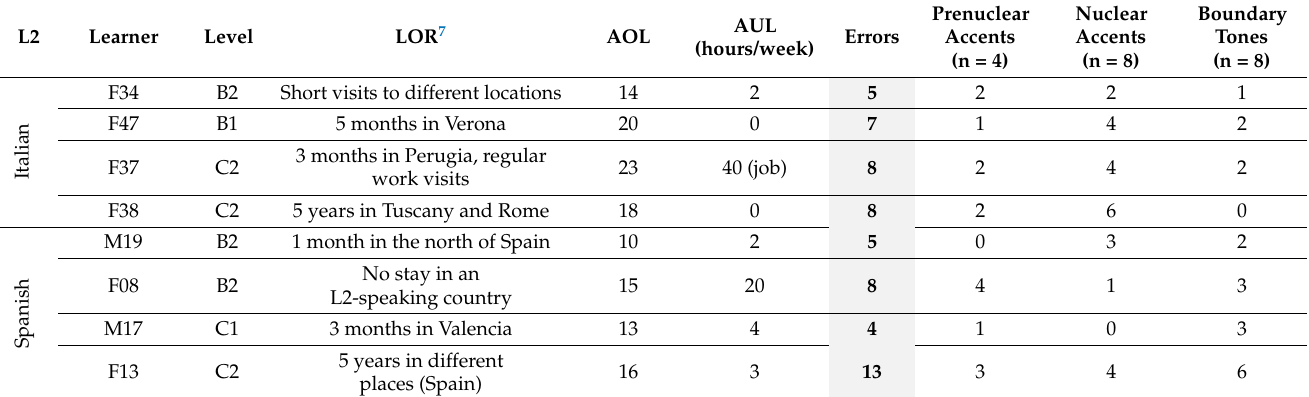
Table 3. Intonation errors of eight selected L2 Italian and L2 Spanish